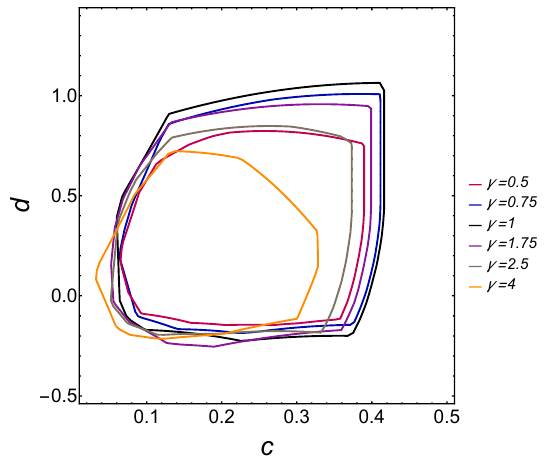
Figure 7 . Positive regions in the ( c, d )-plane with different γ (the regions within the solid lines are allowed by generalized elastic positivity bounds) in the Z κ 3 = 1 . 4 , κ 4 = 0 . 38 , λ = 0 . 2 .